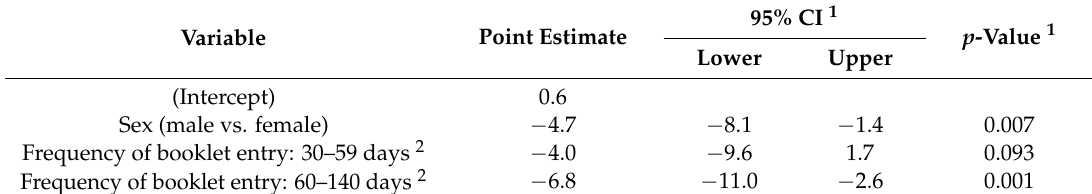
Table 3. Coefficients of the multiple regression model examining the effect of frequency of booklet entry, controlling for sex, on weight change (kg) at 6 months. 95% CI 1 Variable Point Estimate